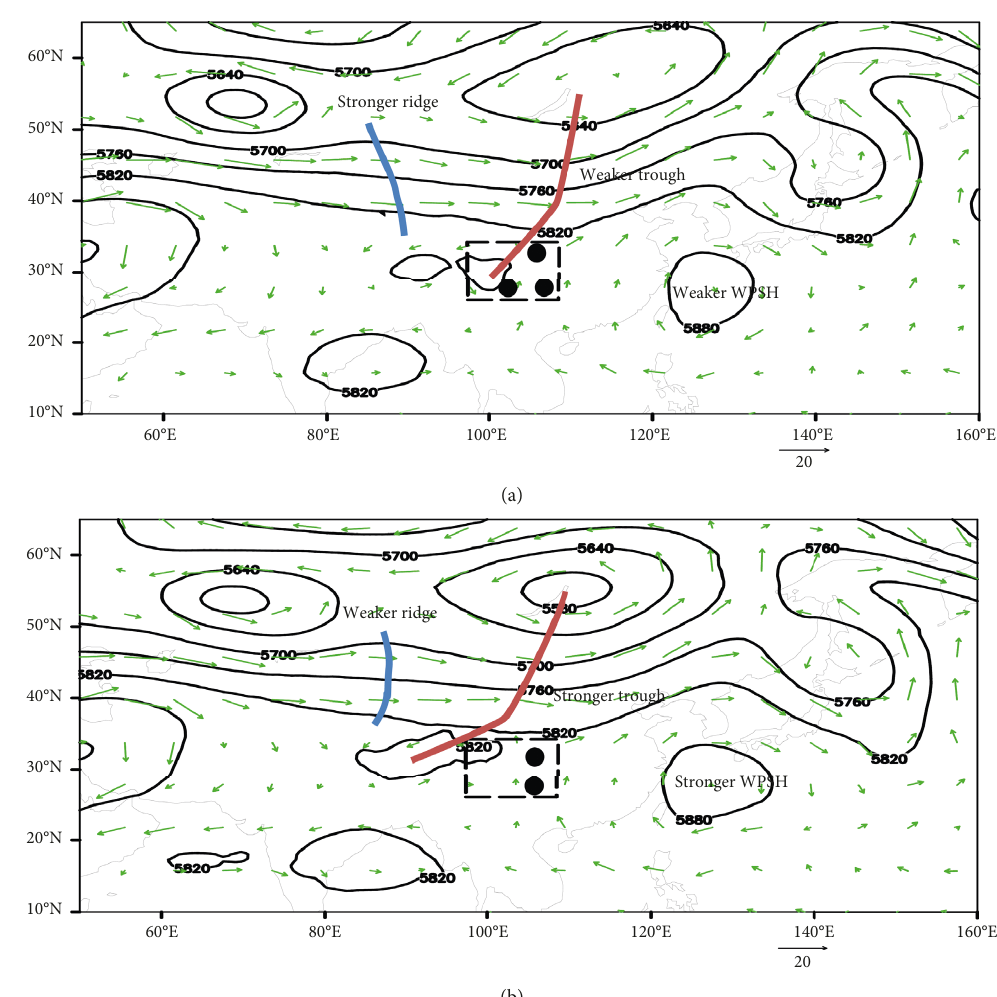
Figure 11: Schematic diagram illustrating the large-scale factors leading to (a) development (stronger members) and (b) non- development (weaker members) of the TPMV and associated precipitation. Three black dots denote more rainfall while two black dots denote less